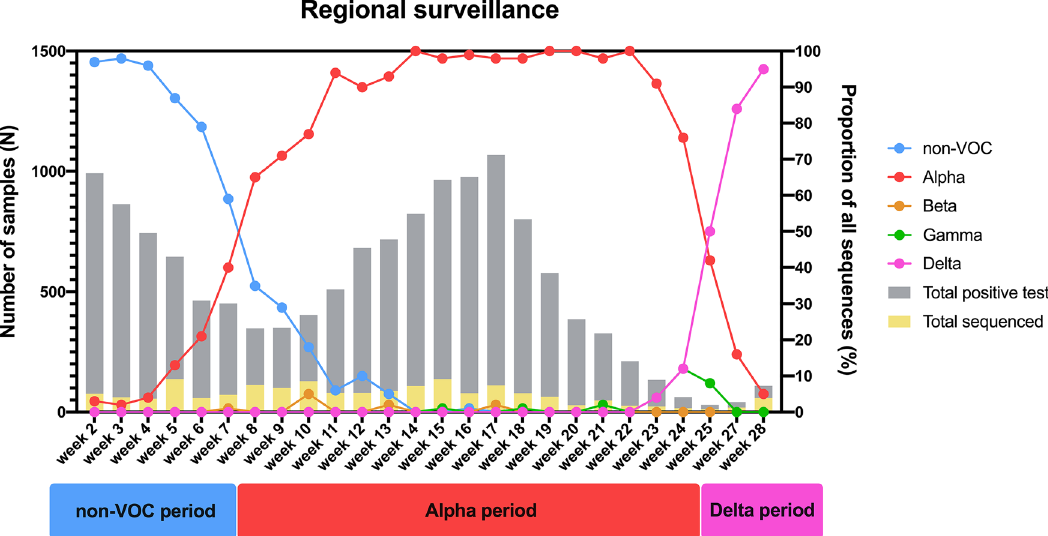
Figure 1. Distribution of circulating variants in the South Limburg region in time. The period during which a particular variant was dominant (> 50% of sequenced samples) is indicated below. Lines represent the relative proportion of each variant, whereas bars represent the total number of samples that were tested positive (grey) or were sequenced (yellow) in function of time. At least 7% of positive samples were sequenced per